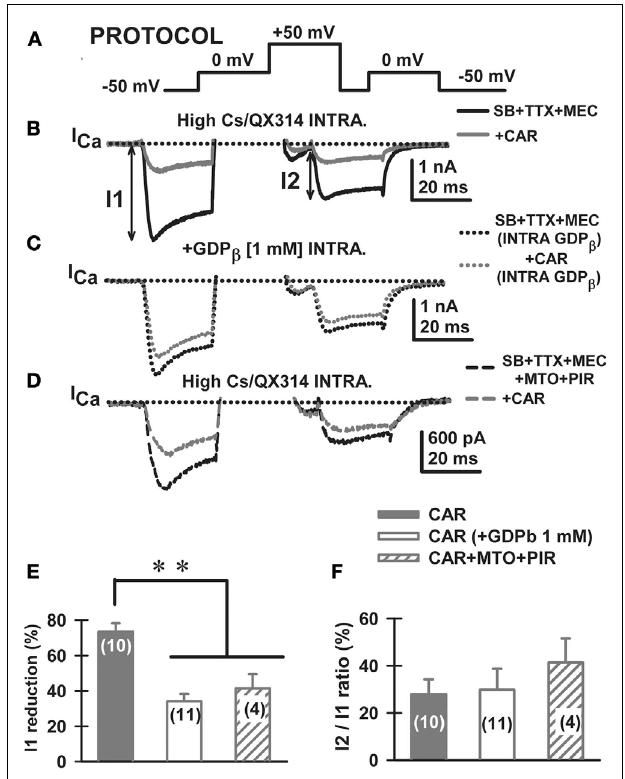
FIGURE 4 | Carbachol-mediated voltage-dependent G-protein modulation of voltage-gated calcium currents in PPN . (A) Three-pulse protocol (see Materials and Methods) used to study the voltage dependence of G-protein modulation of calcium currents (I Ca ) in PPN neurons. (B) In the presence of synaptic receptor blockers (SB: GBZ + STR + AP5 + CNQX),TTX, and MEC, calcium currents (I Ca ; black record) were reduced in amplitude when the three-pulse protocol was applied. Indeed, the I Ca observed after the second 0mV pulse (I2) was